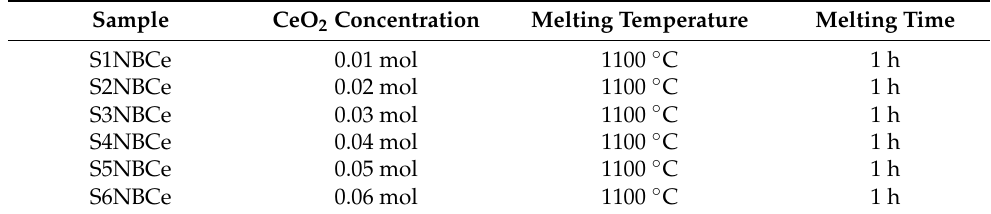
Table 1. Composition/Identification for glasses Na 2 O · 2B 2 O 3 1 doped with different amounts of CeO 2